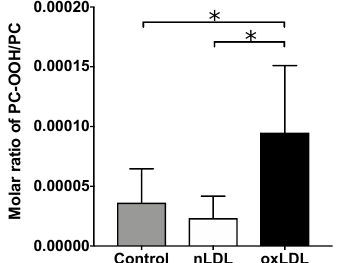
Figure 5. The molar ratio of PC-OOH/PC. Results are shown as mean ± standard deviation. n = 5 – 6. One- way ANOVA with Tukey’s multiple comparisons test, * p < 0.05.